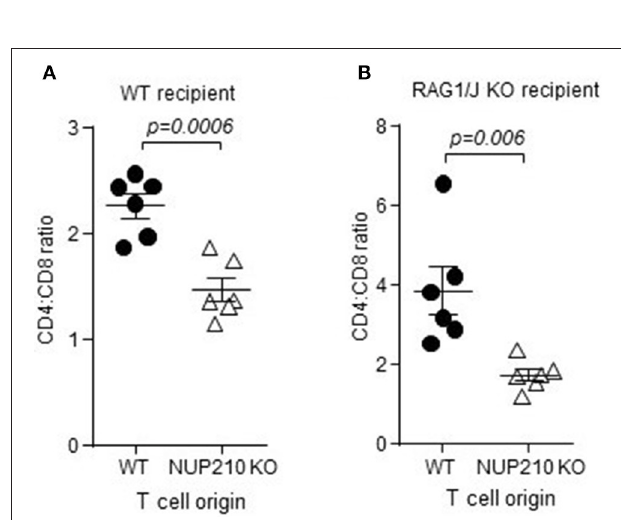
FIGURE 4 | Altered ratio of peripheral CD4:CD8T cells in Nup210 KO mice is due to functions intrinsic to T cells. (A) Wildtype CD45.1 mice were irradiated and reconstituted with 50% bone-marrow from wildtype CD45.1 mice and 50% bone marrow from Nup210 KO CD45.2 mice ( n = 6). At 8 weeks post-reconstitution, the CD4:CD8 ratio in the spleen was assessed by flow cytometry in both the wildtype (CD45.1 + ) and Nup210 KO (CD45.2 + ) compartment. (B) Rag1 KO CD45.2 mice were irradiated and reconstituted with 50% bone-marrow from wildtype CD45.1 mice and 50% bone marrow from Nup210 KO CD45.2 mice ( n = 6). At 8 weeks post-reconstitution, the CD4:CD8 ratio in the spleen was assessed by flow cytometry in both the wildtype (CD45.1 + ) and Nup210 KO (CD45.2 + ) compartment. Mean ± SEM, with individual data